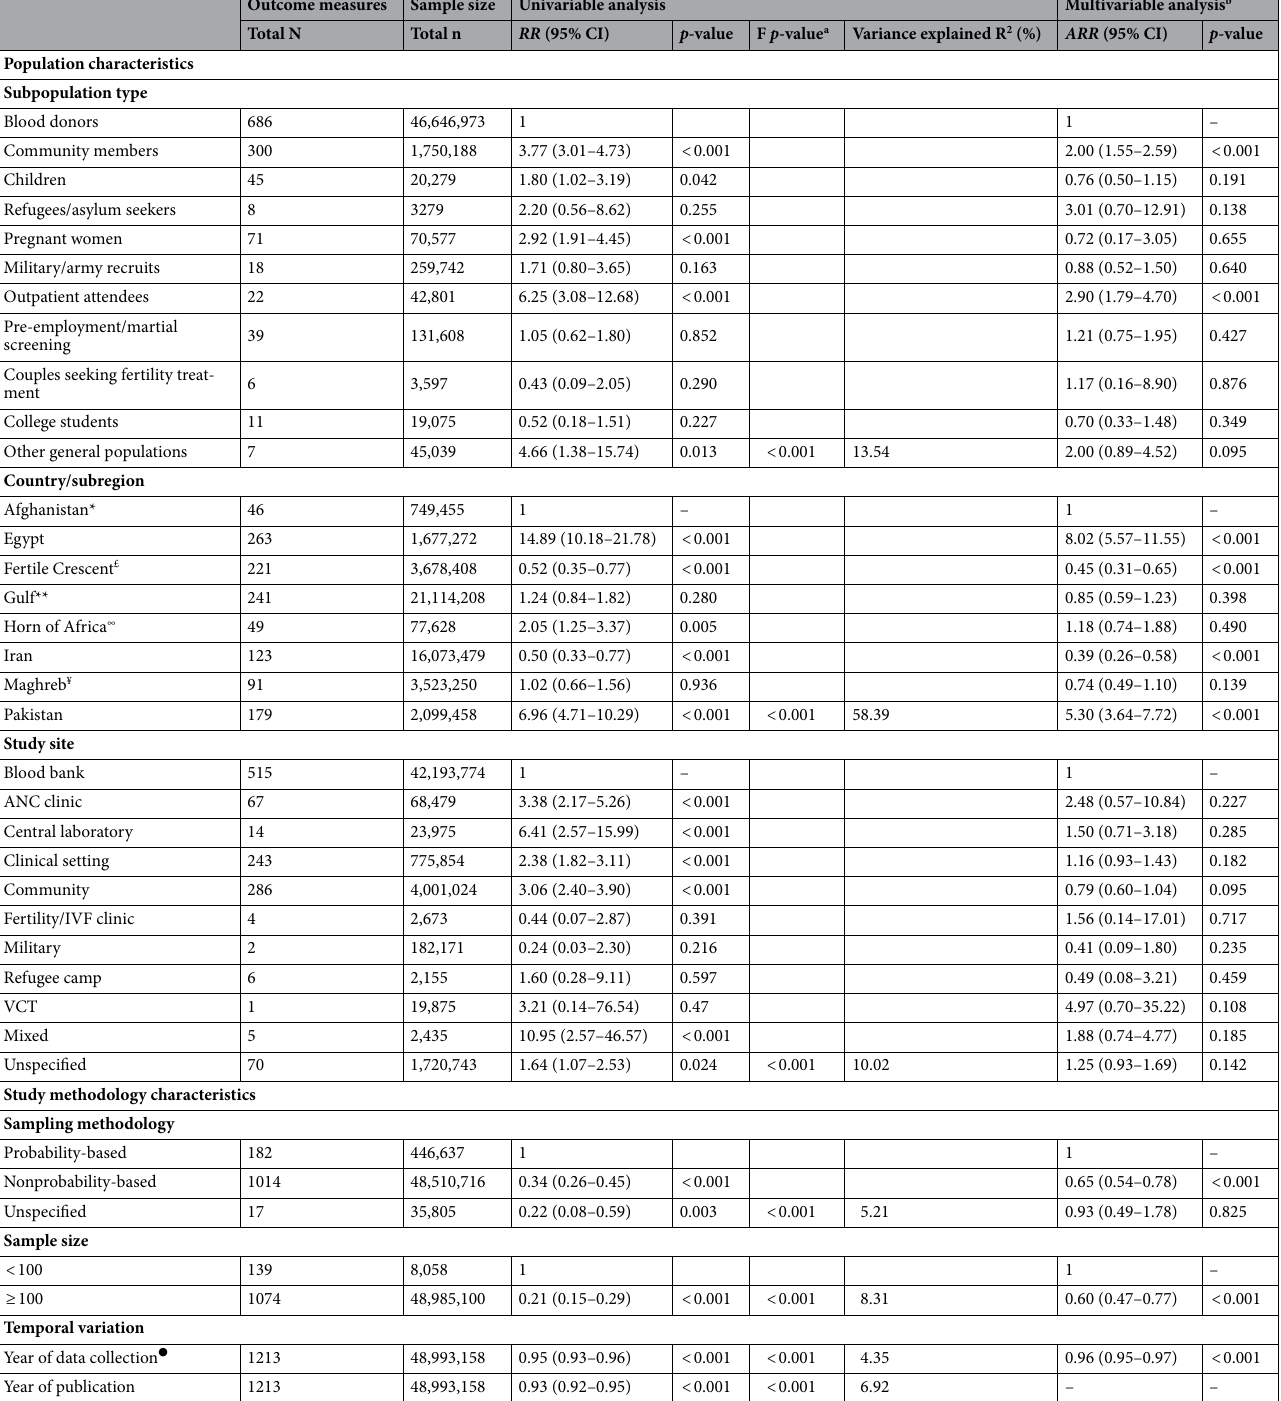
Table 4. Univariable and multivariable meta-regression analyses for HCV Ab prevalence in the general population in the Middle East and North Africa. Abbreviations: Ab, antibody; ANC, antenatal care; ARR, adjusted relative risk; CI, confidence interval; HCV, hepatitis C virus; RR, relative risk; VCT, voluntary counseling and testing. *Afghanistan was chosen as a reference country given the availability of considerable number of studies in the general population, low HCV prevalence in the general population, and being the first country alphabetically to qualify accordingly. £ Countries include Iraq, Jordan, Lebanon, Palestine, and Syria. **Countries include Bahrain, Kuwait, Oman, Qatar, Saudi Arabia, and United Arab Emirates. ∞ Countries include Djibouti, Somalia, Sudan, and Yemen. ¥ Countries include Algeria, Libya, Mauritania, Morocco, and Tunisia. ● Due to collinearity between year of data collection and year of publication, the multivariable analysis included only one of these variables, year of data collection. a Variables with a p-value ≤ 0.2 were eligible for inclusion in the multivariable analysis. b The adjusted R-squared for the full model was